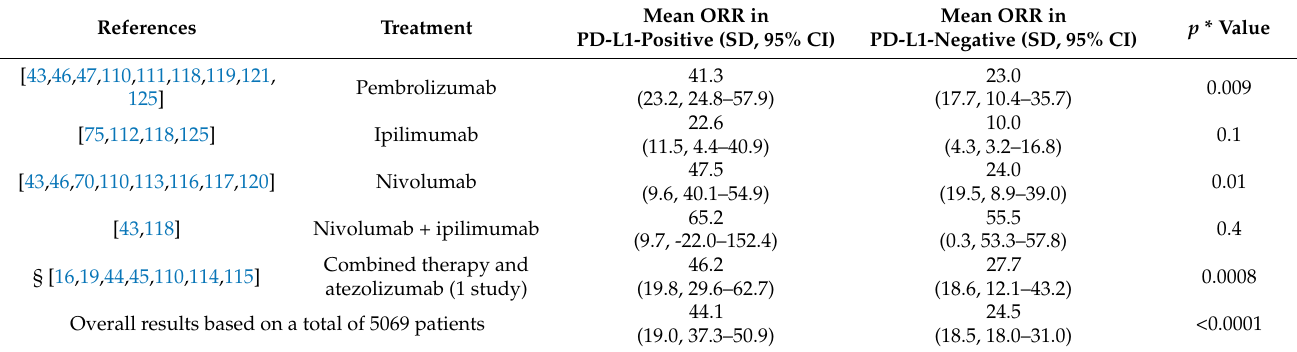
Figure 1. Forest plots of odds ratio (in log scale) of response to ICI (checkpoint inhibitor) in metastatic or non-resectable melanoma patients according to positivity to PD-L1 by immunohistochemistry. Meta-analysis was sub-grouped according to ICI treatment. The size of squares mirrors the weight of the study in the meta-analysis. Table 2. ORR in PD-L1-positive and -negative strafied by treatment